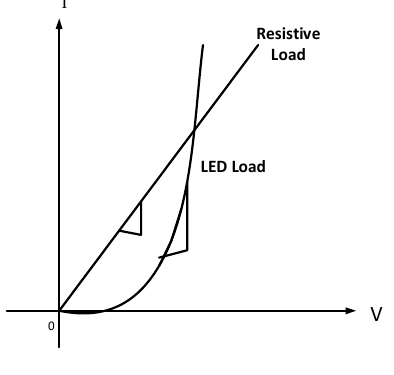
Figure 3. LED load Figure 3. LED load model.